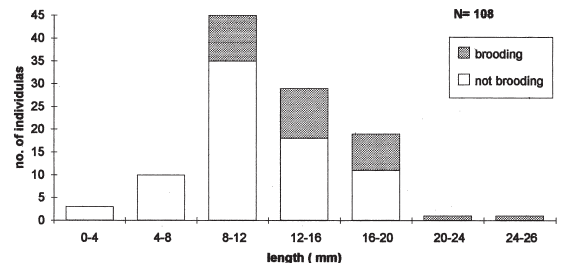
F IG . 1. – Relationships between body length (crown excluded) and F IG . 2. – Size frequency distribution of brooding and not brooding wet weight (A) (N= 73, r= 0.75, P< 0.01, Y = -12.33 + (3.45 X)), specimens of the Perkinsiana antarctica population sampled and between body width and wet weight (B) (N= 73, r= 0.80, P< 0.01, Y = 1.25 + (0.02 X)).